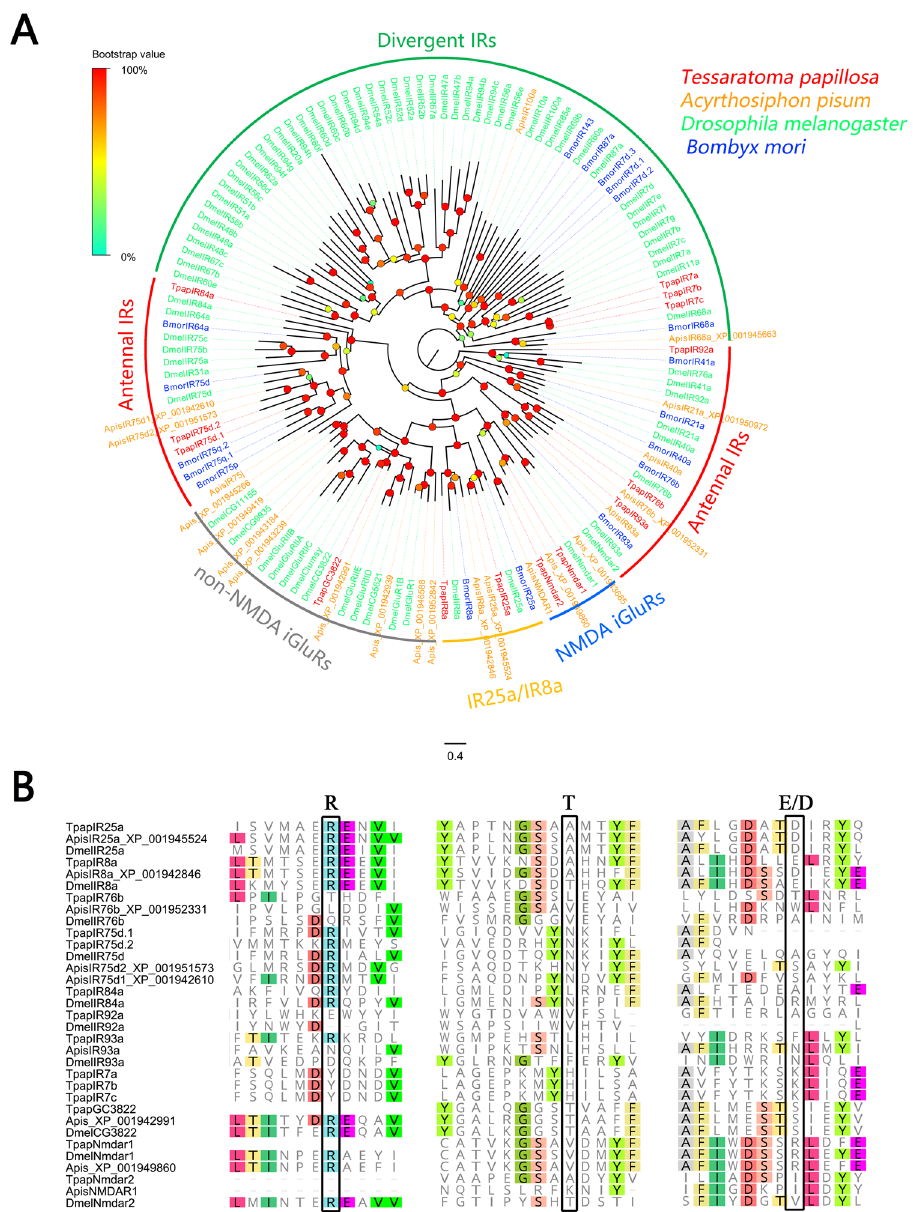
Figure 4. ( A ) Phylogenetic analysis of putative T . papillosa iGluRs/IRs in with other insect iGluRs/IRs. The dendrogram was generated by FastTree2 (JTT substitution model). Species abbreviations: Tpap, Tessaratoma papillosa ; Apis, Acyrthosiphon pisum ; Bmor, Bombyx mori ; Dmel, Drosophila melanogaster . Amino acid sequences used to construct the tree are shown in Supplementary Table S2. Branch support (circles at the branch nodes) was estimated using an approximate likelihood ratio test based on the scale indicated at the top left. Bars indicate branch lengths in proportion to amino acid substitutions per site. ( B ) Excerpts from the amino acids alignment showing the predicted iGluRs/IRs binding